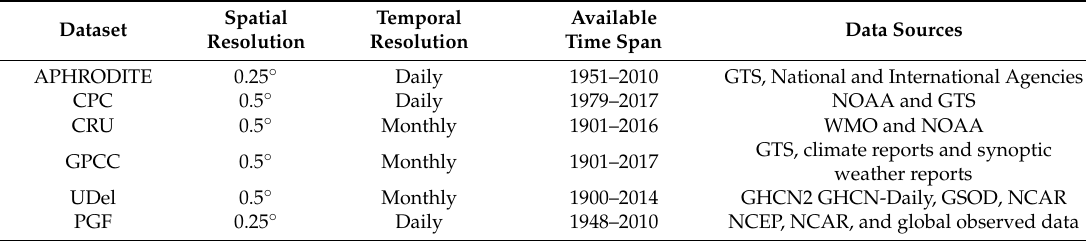
Table 2. Summary of the gridded rainfall datasets evaluated in the present